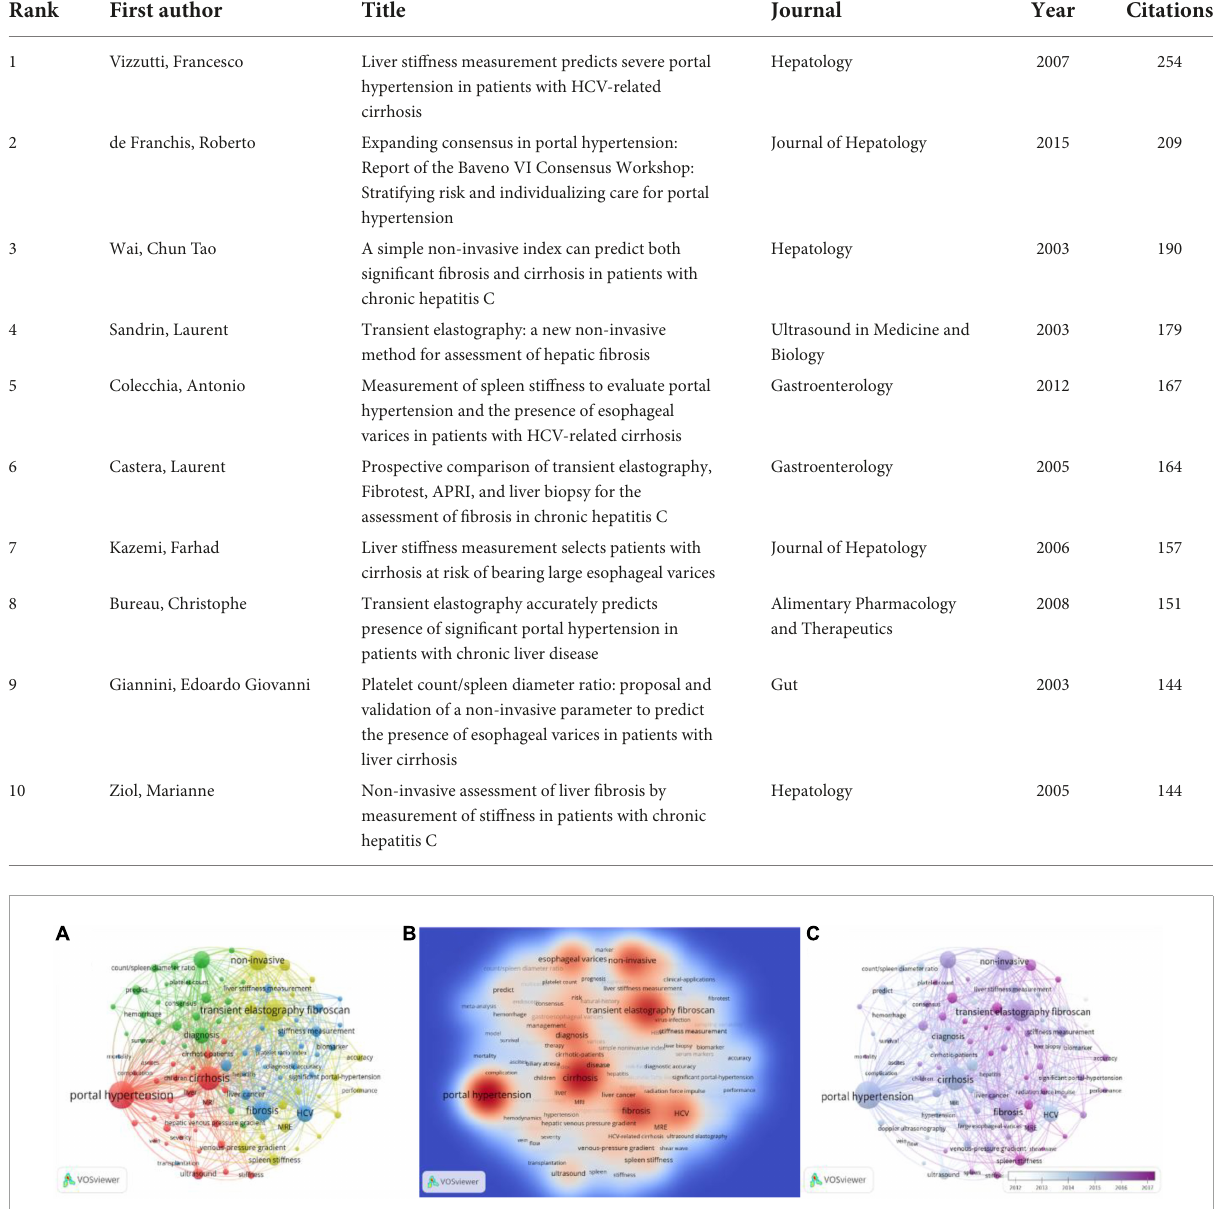
FIGURE4 The co-occurrence analysis of keywords occurred over 20 times. (A) Shows the number of times the keywords appear and how they relate to one another. The size of the circles indicates how often they appear, the lines between the circles indicate how connected they are, and the thickness of the lines indicates how close the relationship is. (B) Shows the current research hotspots in keywords, and the red circles represent the research hotspots. (C) The color of the timeline in the lower right corner represents the year in which the keywords appeared.